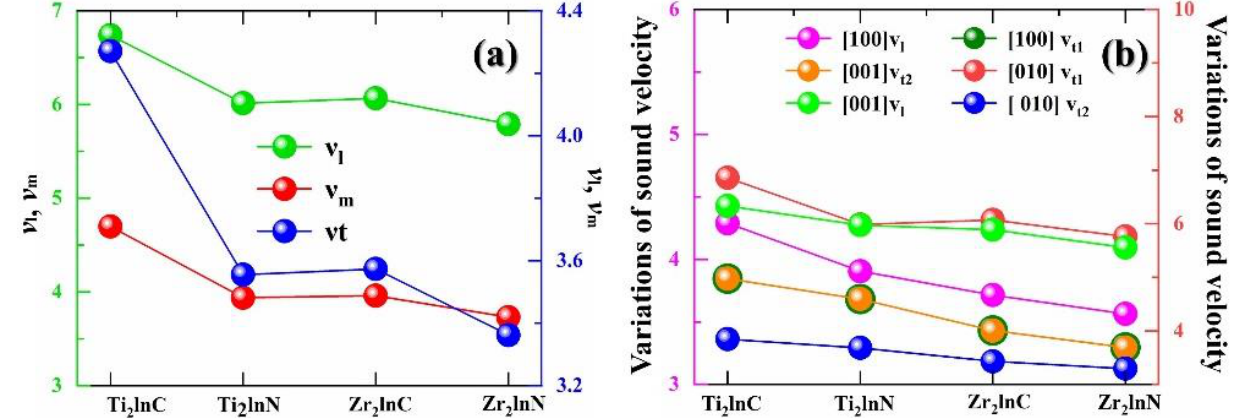
Figure 9. ( a ) Variations in sound velocity of M 2 InX (M = Ti, Zr and X = C, N) MAX phases; ( b ) Directional sound velocity of M 2 InX (M = Ti, Zr and X = C, N) MAX phases. Table 7. Anisotropic sound velocities (m/s) of M 2 InX (M = Ti, Zr and X = C, N) MAX phases.